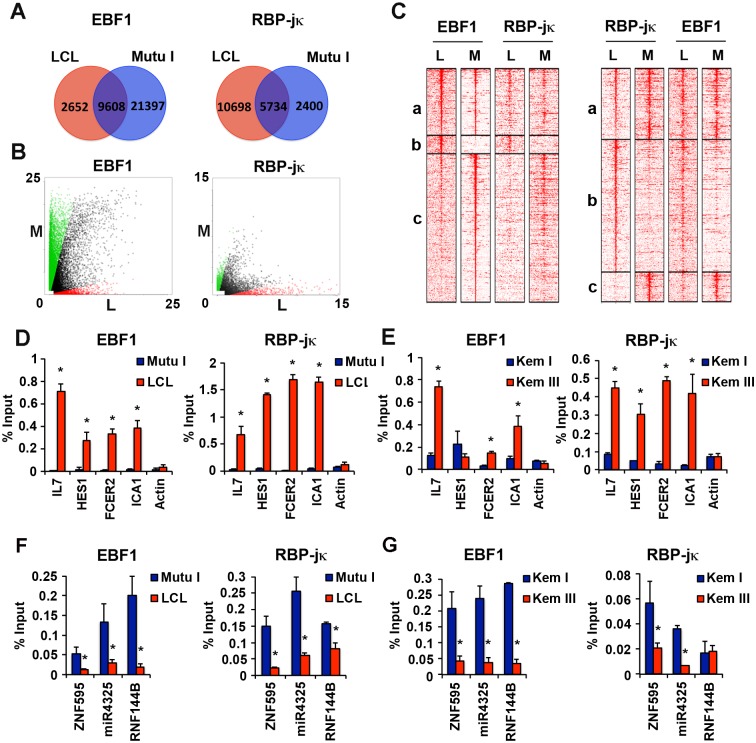
Differential binding of transcription factors on cellular genome in type I and type III infected B-lymphocytes.
(A) Venn diagram showing EBF1 and RBP-jκ occupancy sites specific to LCL (red) and Mutu I (blue) or common to both cell types. (B) Scatter plot showing the distribution of EBF1 (left) or RBP-jκ (right) occupancies that are specific to either LCL (L, red) or Mutu I (M, green) or common to both cell types (grey). (C) Heatmaps showing co-occupancy of EBF1 and RBP-jκ from either LCL (L) or Mutu I (M) cells, centered on either EBF1 in LCL (left panel) or RBP-jκ in LCL (right panel). Binding sites were clustered based on their common occurrence in MutuI and LCL (a), LCL-specific (b), or Mutu I-specific (c). (D and F) ChIP-qPCR validation for various cellular gene ChIP-Seq peaks for EBF1 (left) or RBP-jκ (right) in either Mutu I (blue) or LCL (red) cells. (E) Same as in (D) except for Kem I and Kem III cell types. (G) Same as in (F) except for Kem I and Kem III cell types. Asterisk indicates p < 0.05.